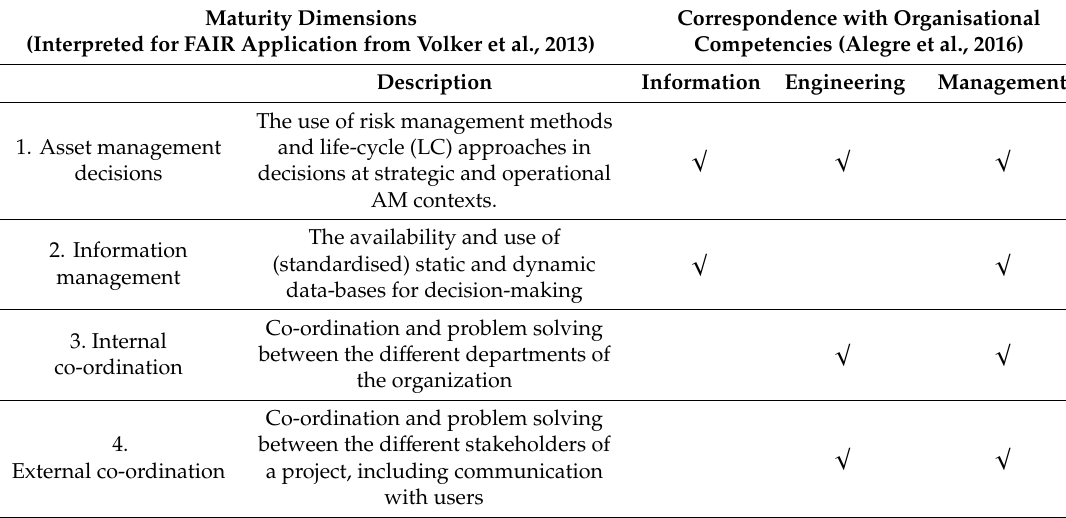
Table 1. Organisational dimensions used in the FAIR maturity